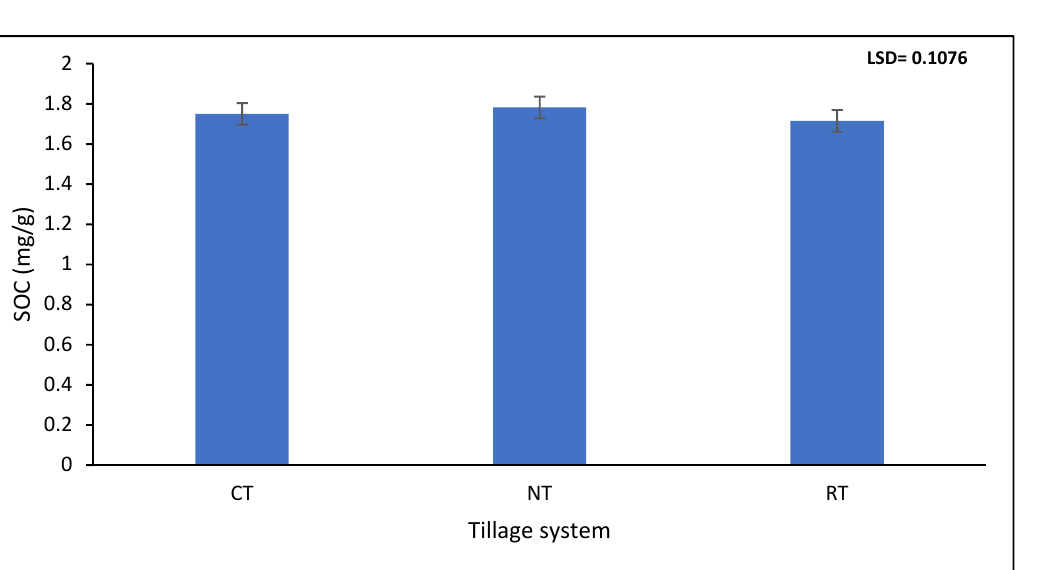
Figure 5. Soil organic carbon (SOC) at three different tillage treatments of no-till (NT), rotational tillage (RT), and conventional tillage (CT) after 17 years of trial